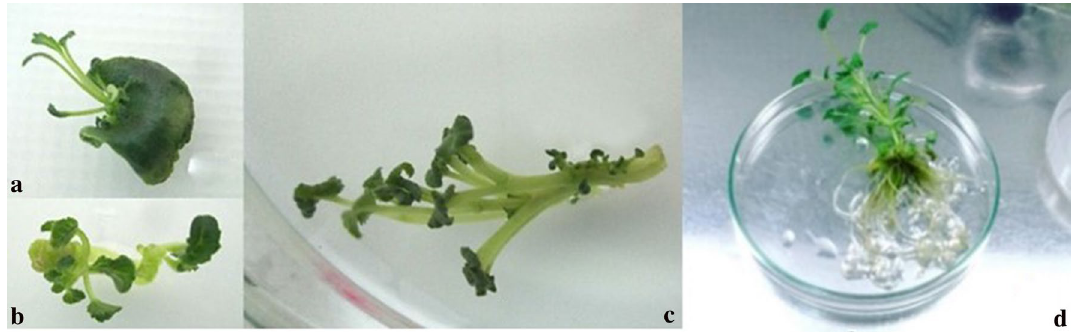
Figure 2. Response of explants on plant regeneration medium containing 1 mg l −1 BAP plus 0.05 mg l